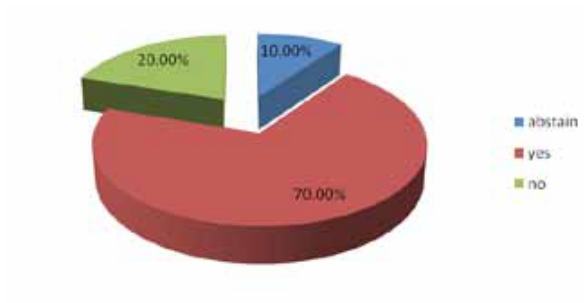
Graph 2: Percentage of Respondent Batik SMEs Having